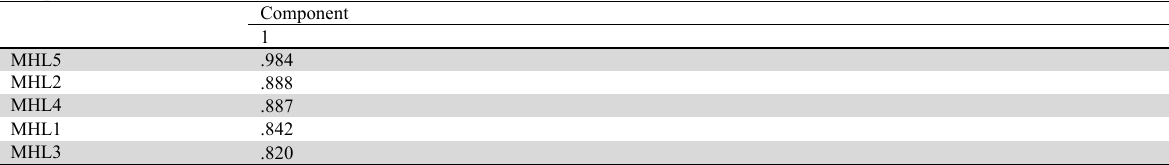
Component matrix